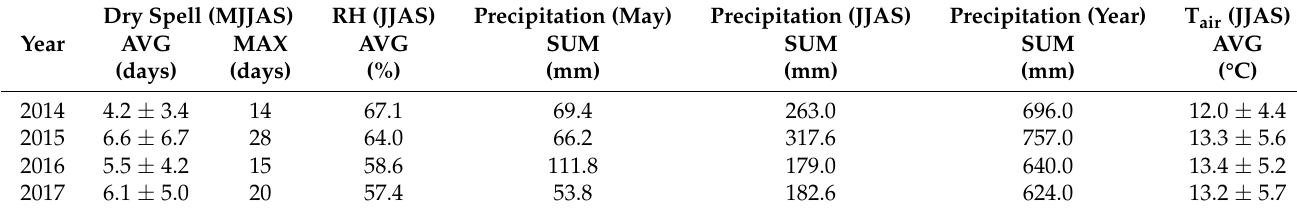
Table 2. Average and maximum dry spell for May-to-September (MJJAS) periods and average relative humidity (RH) for June-to-September (JJAS) periods. Cumulative precipitation for May, June-to- September periods and for the hydrological years. Average air temperature ( T air ) for the JJAS period. The range reported for the average dry spell and air temperature is one standard deviation.